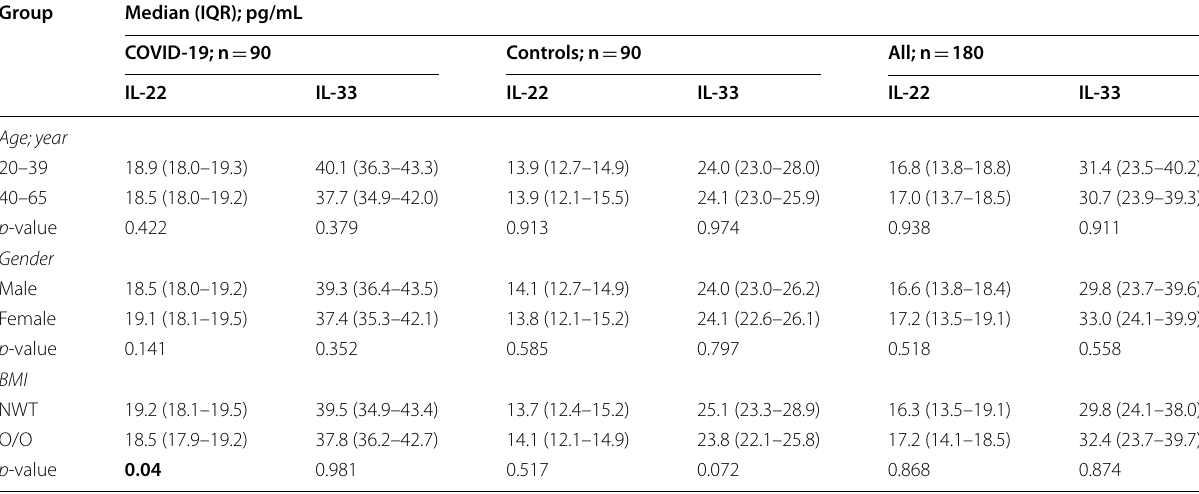
Table 2 Serum interleukin (IL-22 and IL-33) concentrations stratified by age group, gender, and body mass index in COVID-19 cases, controls, and all participants (patients plus